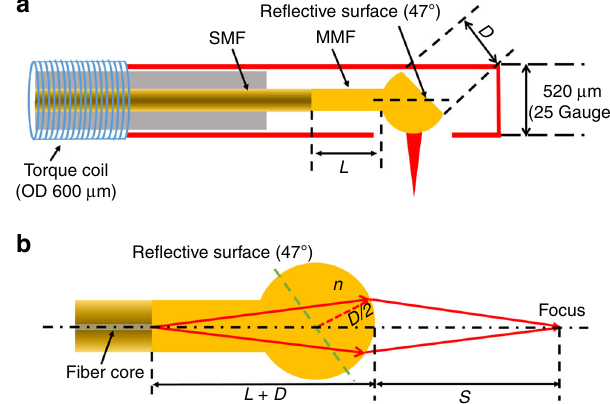
Fig. 1 Schematic of the fi ber ball lens-based microprobe. a The design of microprobe operating at 800 nm. SMF: single-mode fi ber, MMF: multi- mode fi ber, OD: outer diameter. b An equivalent forward-viewing design of microprobe. L length of the MMF, D diameter of the fi ber ball lens, n